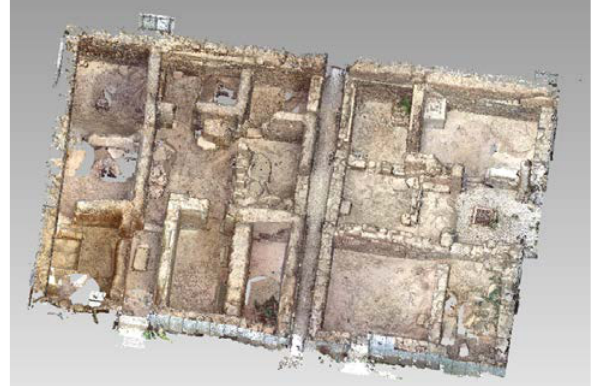
Figure 12. Point cloud produced from laser scanner survey for the two houses.